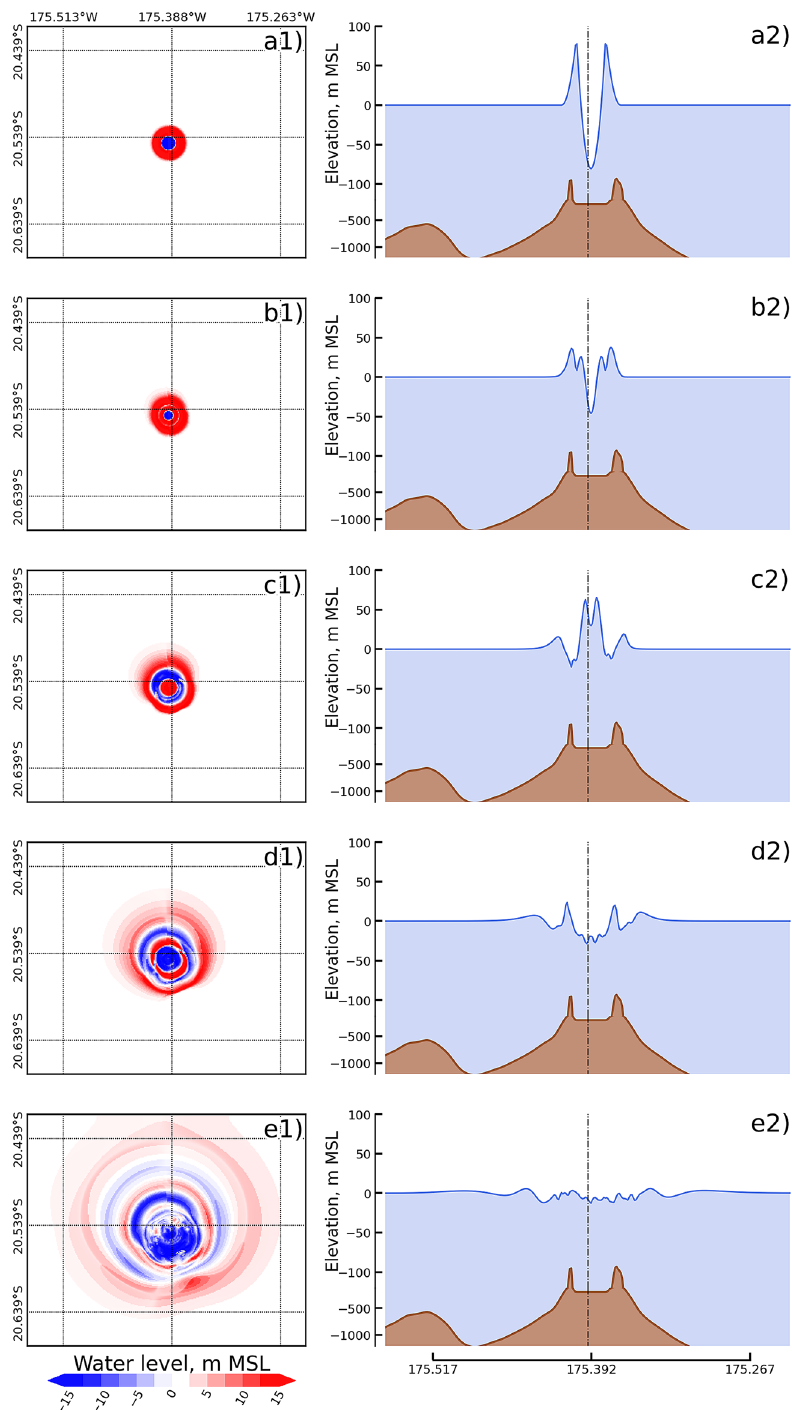
Figure 3. Tsunami generation for the scenario of 25 Mt with the deep sea depth condition: the first column presents the spatial data, and second column presents the profile at 20.545 second, ( d ) 1 min, and ( e ) 2